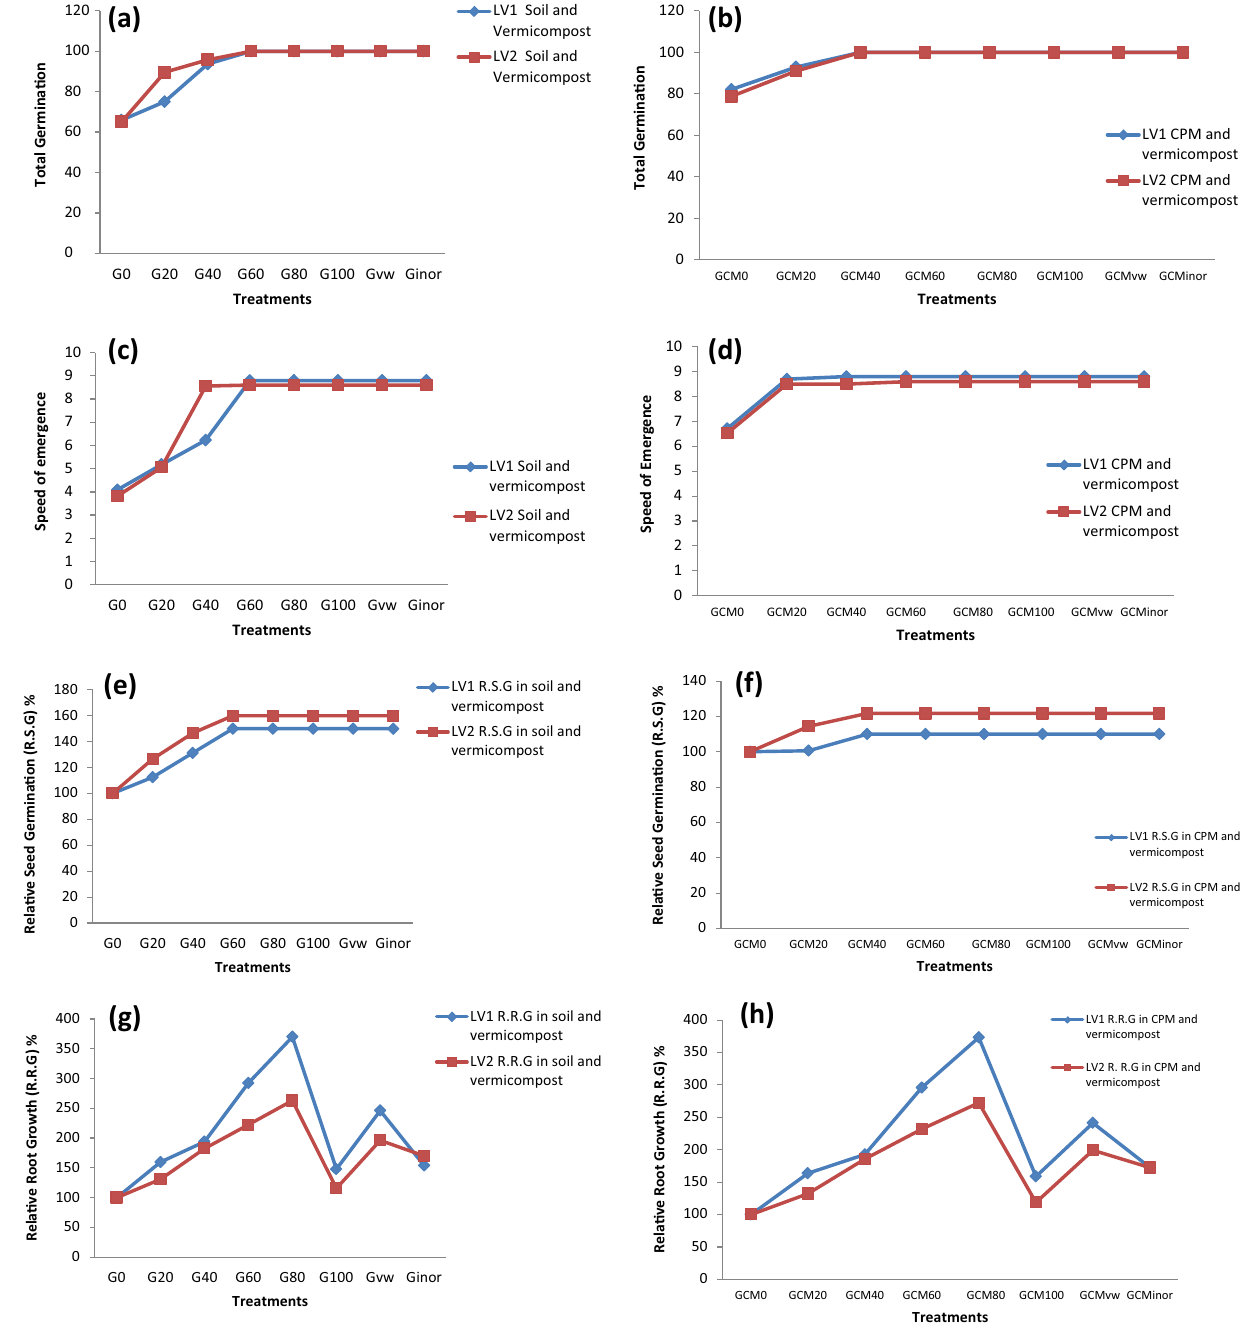
Fig. 1 Analysis of various seedling growth parameters in two varieties Linseed Plants LC- 54 (LV 1 ) and LC- 2063 (LV 2 ): a , b total germination; c , d speed of emergence; e , f relative seed germination; g , h relative root growth under different (S.V.I) showed significant difference ( p \ 0.05) and was highest with dosage of 60% v/v vermicompost, irrespective of substrate being soil or commercial potting media (Table 5). Substituting soil and commercial potting media with vermicompost show comparable S.V.I and Germina- tion Index (G.I) in treatments G